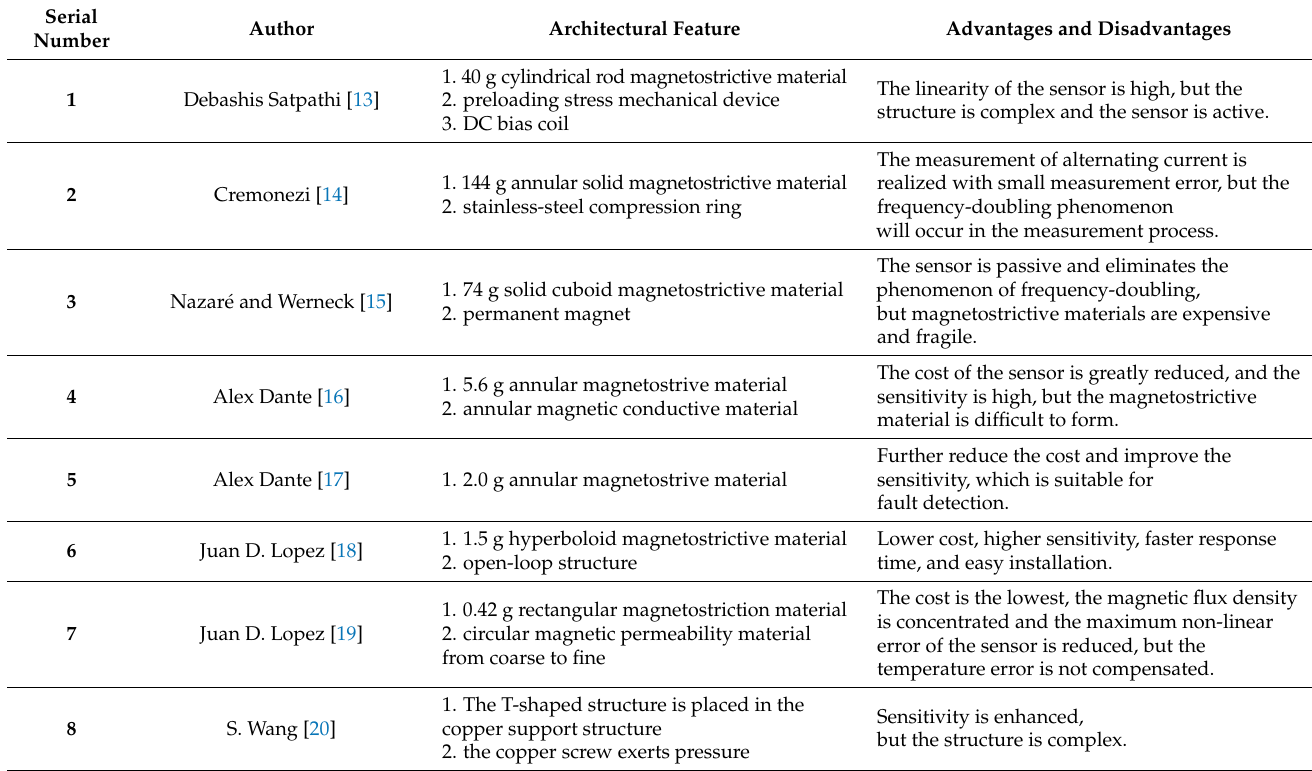
Figure 14. Optical fiber current sensor based on magnetostrictive material with enhanced sensitivity. Table 2. Research summary of sensor structure.